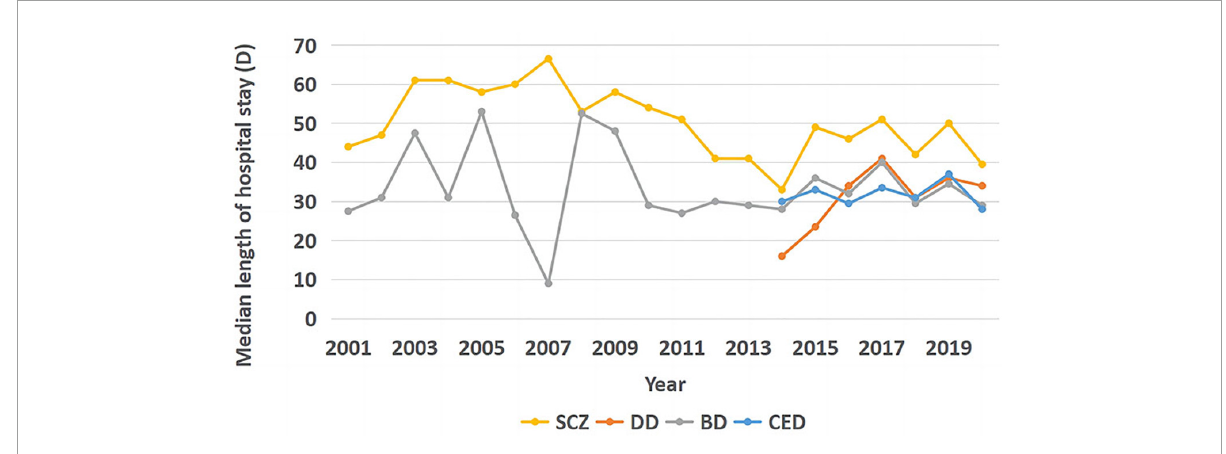
FIGURE2 Trends in median length of stay for the four